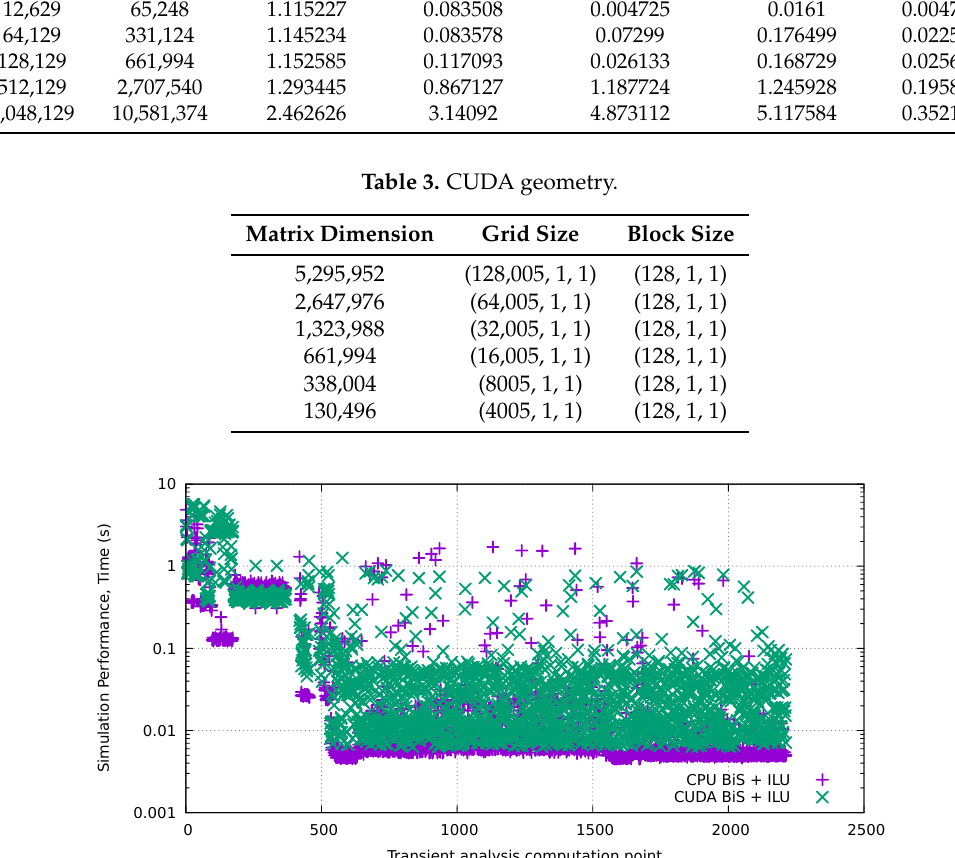
Figure 3. Transient simulation